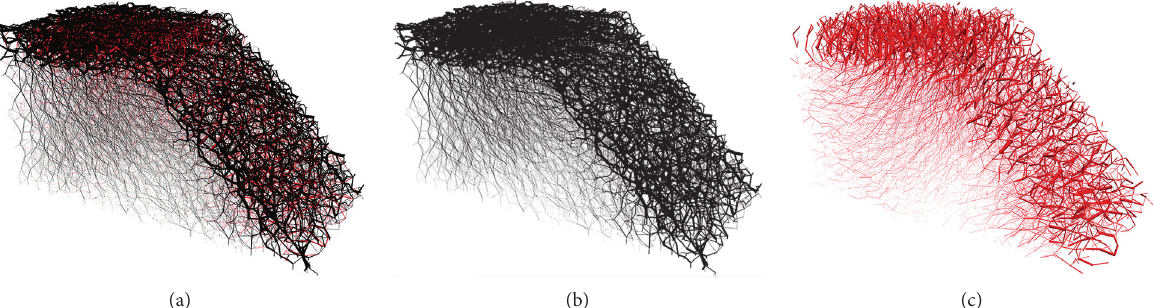
Figure 10: Contact forces chain, pressure, and tension distribution at 20% frozen depth. (a) Contact force chain. (b) Pressure. (c) Tension.